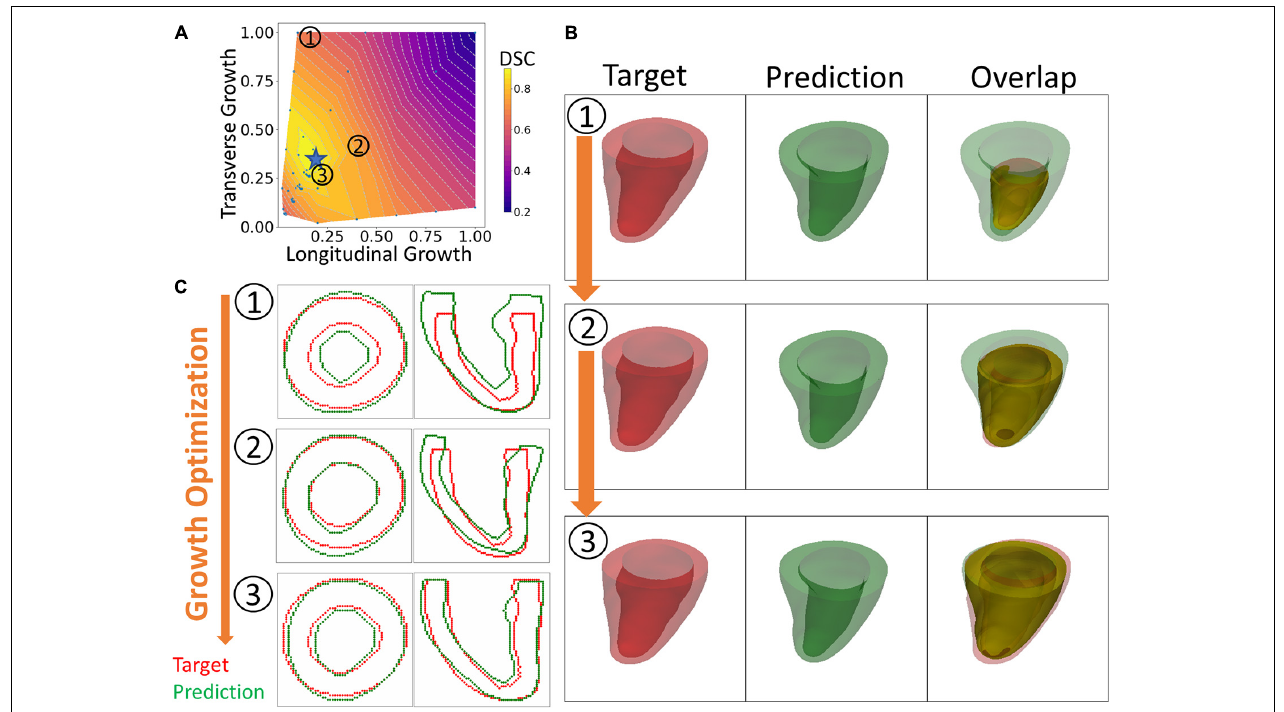
FIGURE 3 | An overview of the results. (A) Heatmap of DICE scores (DSC) for different sets of growth parameters. (B) 3D views comparing predicted and targeted geometries at three different scenarios indicated on the heatmap. (C) 2D contour comparison of predicted and targeted geometries from the long and short axis views. (1) to (3) indicate three different sets of growth parameters that were tested during the optimization process. From (1) to (3), the BO method increasingly finds solutions that improve the DICE